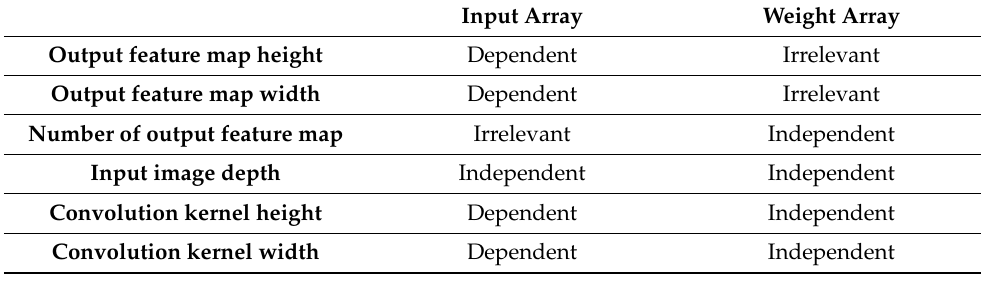
Table 2. Data dependencies relationship of HLS code.